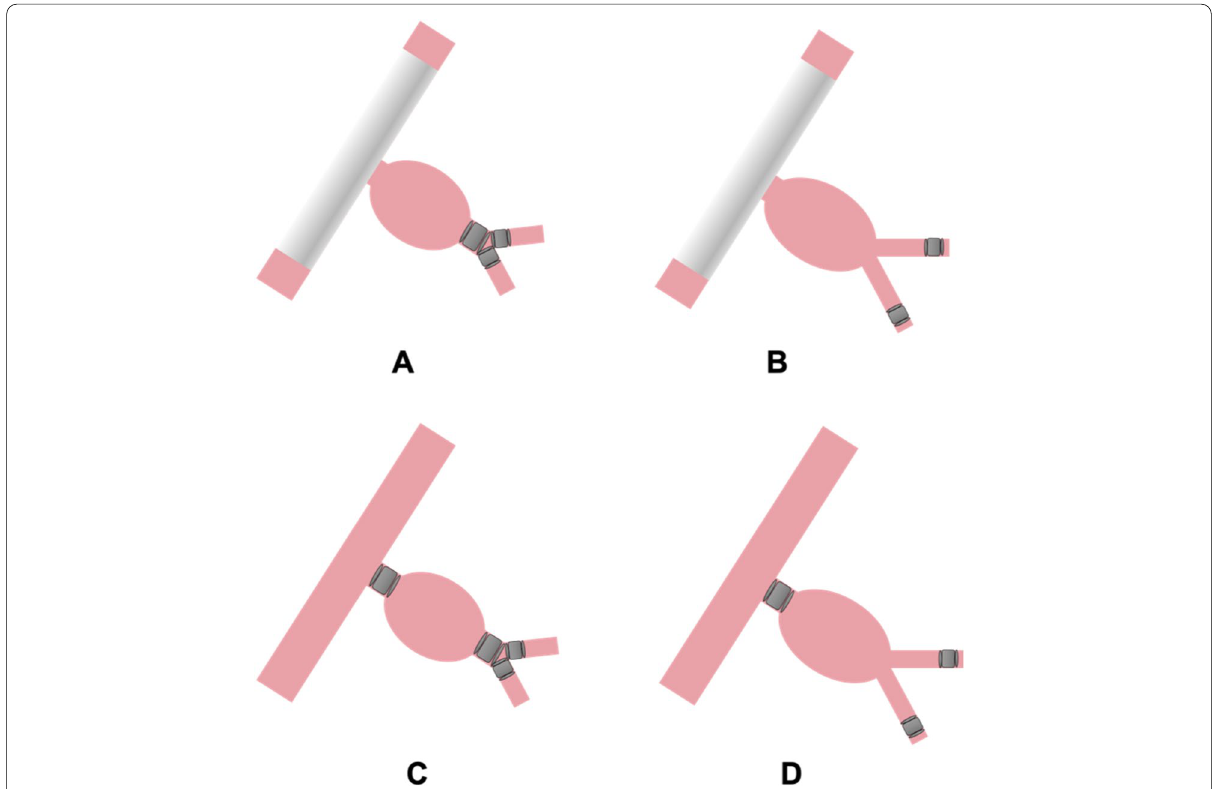
Fig. 1 Type of endovascular technique. A and B Iliac stent graft deployed over the ostium of the IIA following outflow embolization. C and D Embolization of the inflow and outflow of the IIA. A and C Outflow embolization by placing embolic materials in the distal segment of the IIA or its bifurcation. B and D Outflow embolization by placing embolic materials in the distal branches beyond the bifurcation of the anterior and posterior